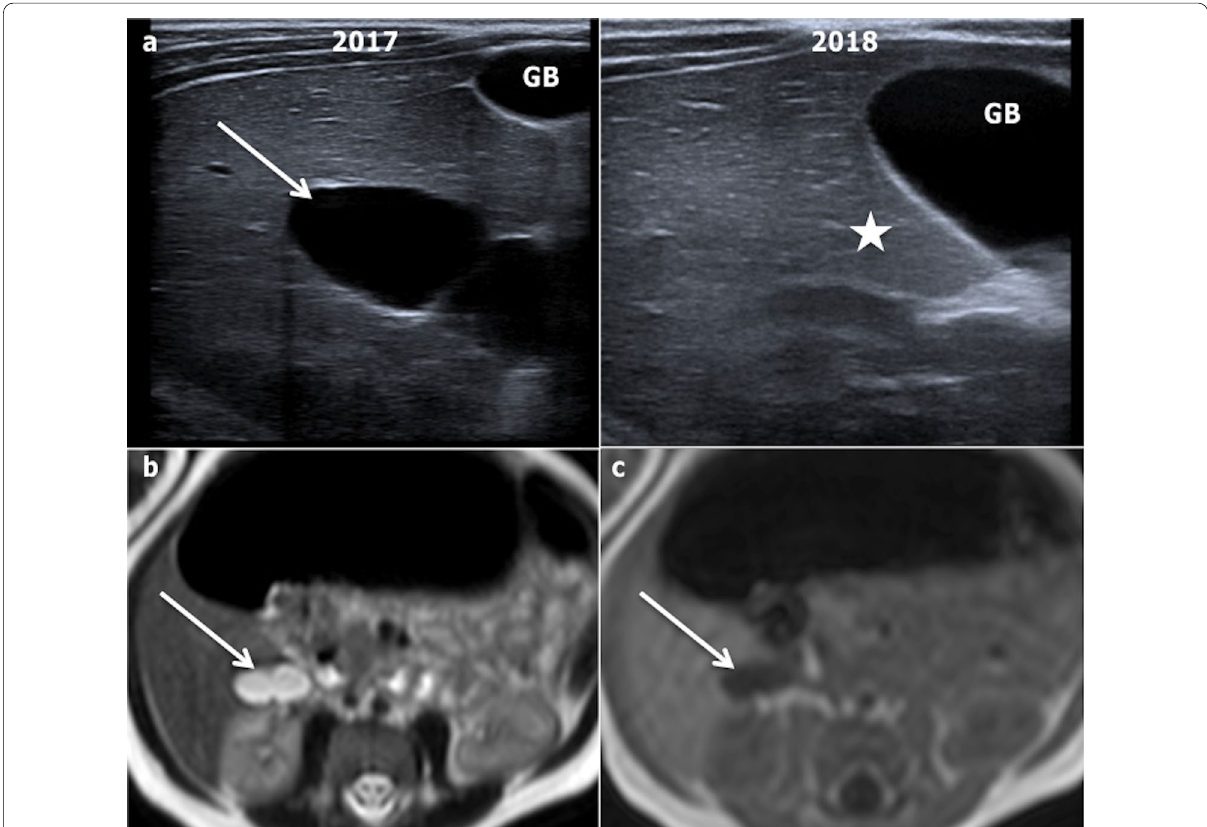
Fig. 17 Spontaneous disappearance of a cystic lesion in a 5-year-old boy between 2017 and 2018, which led to the diagnosis of this lesion as a most likely liver lymphatic malformation. a Ultrasonography shows biloculated homogeneous cyst (arrow), which vanished one year later (star). It displayed fluid signal (arrows) on axial T2-weighted ( b ) and T1-weighted magnetic resonance imaging in 2017 ( c ). The main differential diagnosis of this lesion would be two fused simple hepatic cysts or mesenchymal